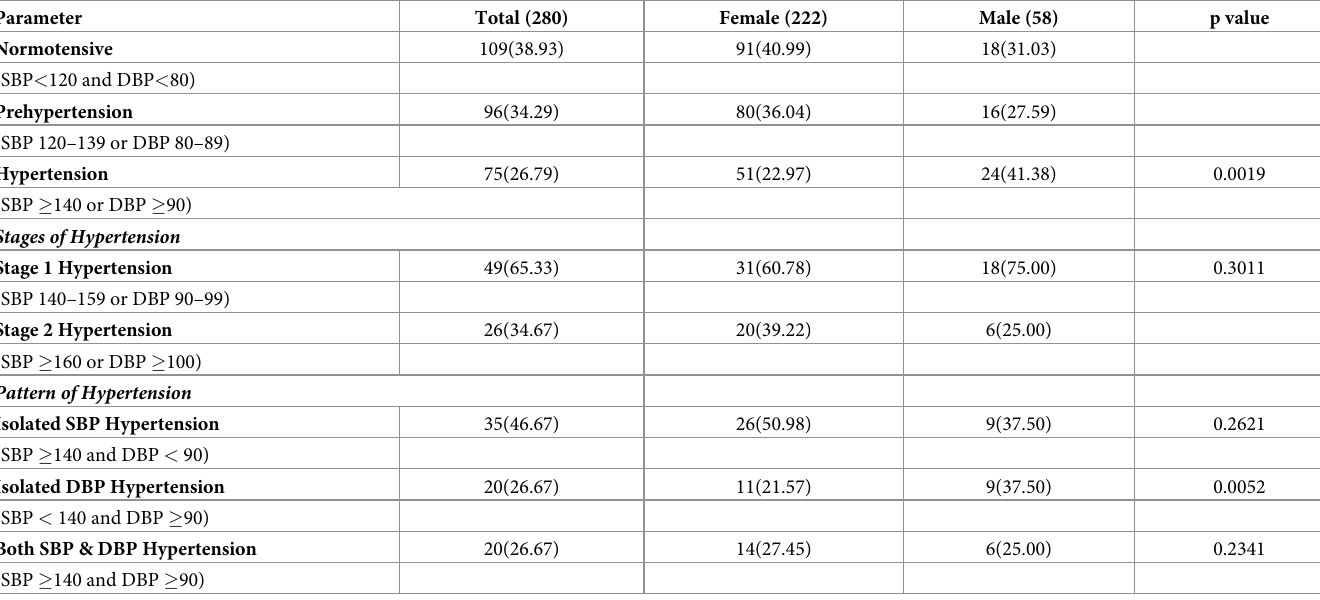
Table 3. Prevalence of undiagnosed hypertension and haemodynamic presentation of community residents in Nyive. Parameter